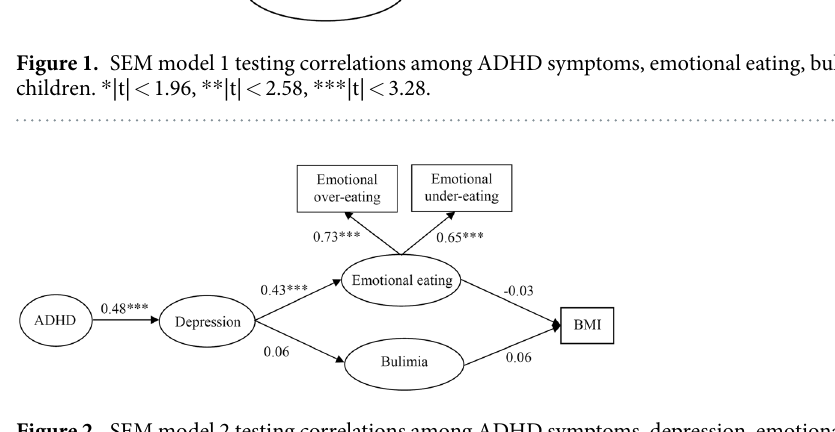
Figure 2. SEM model 2 testing correlations among ADHD symptoms, depression, emotional eating, bulimia and BMI in children. * |t| < 1.96, ** |t| < 2.58, *** |t| <